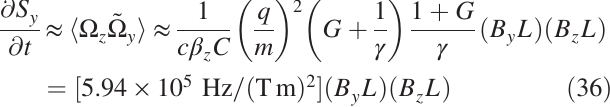
˜ Ω and Ω yields a y z